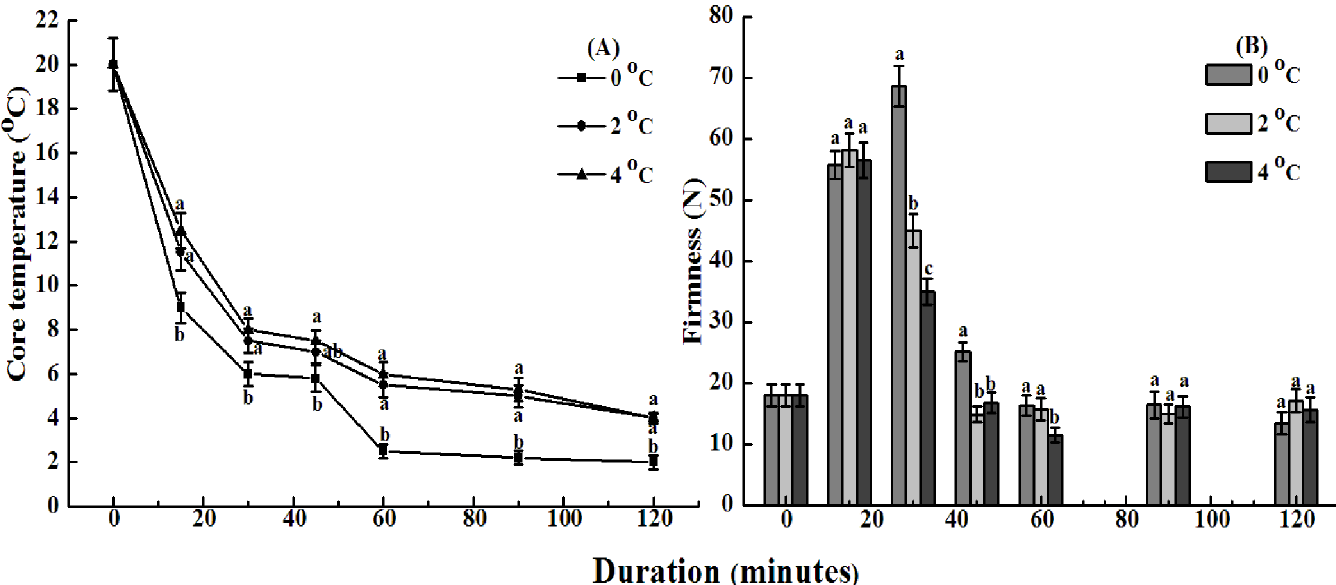
Fig 1. Changes in core temperatureof avocado fruits treated with cold shock at 0, 2 or 4 ˚ C for 0 to 120 minutes (A) and the corresponding firmness after 6-day storage at 20 ˚ Cand 85–90%RH (B). Different letters at any storage time indicate significantdifferences (P < 0.05).